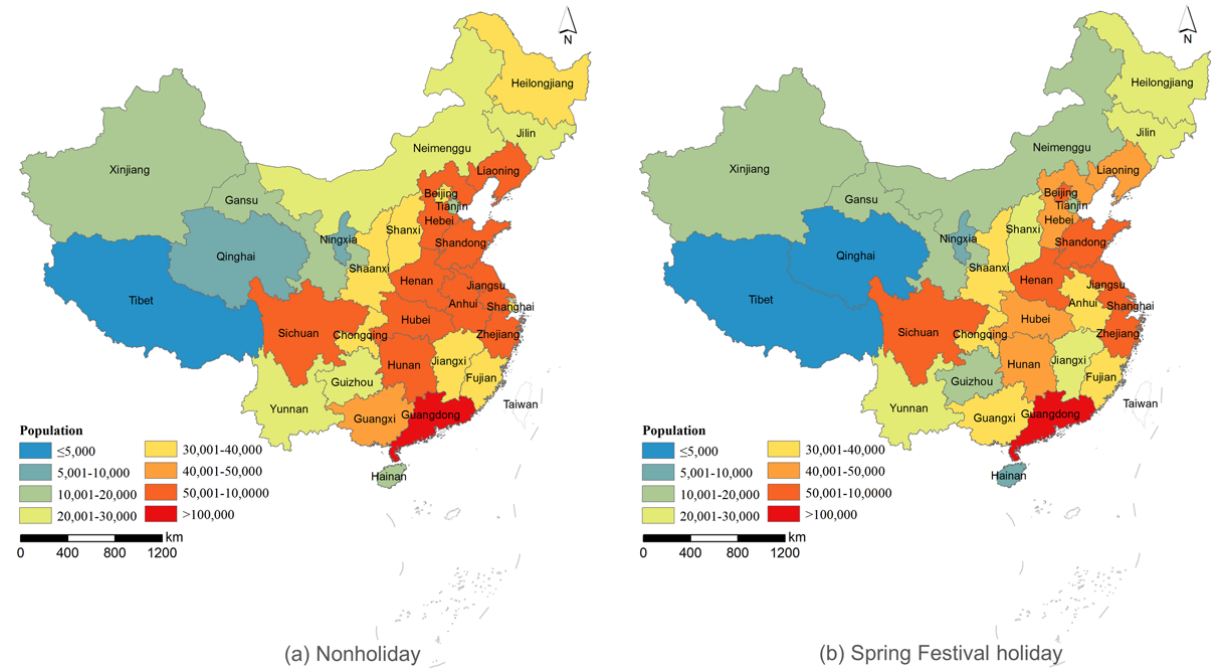
Figure 2. Spatial distribution patterns of daily online MSM from the Blued